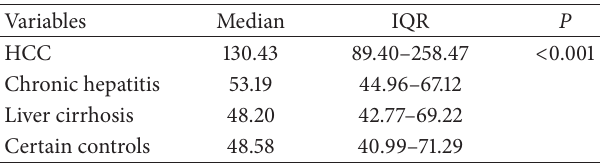
Table 3: The serum SALL4 levels in HCC and controls (pg/mL).